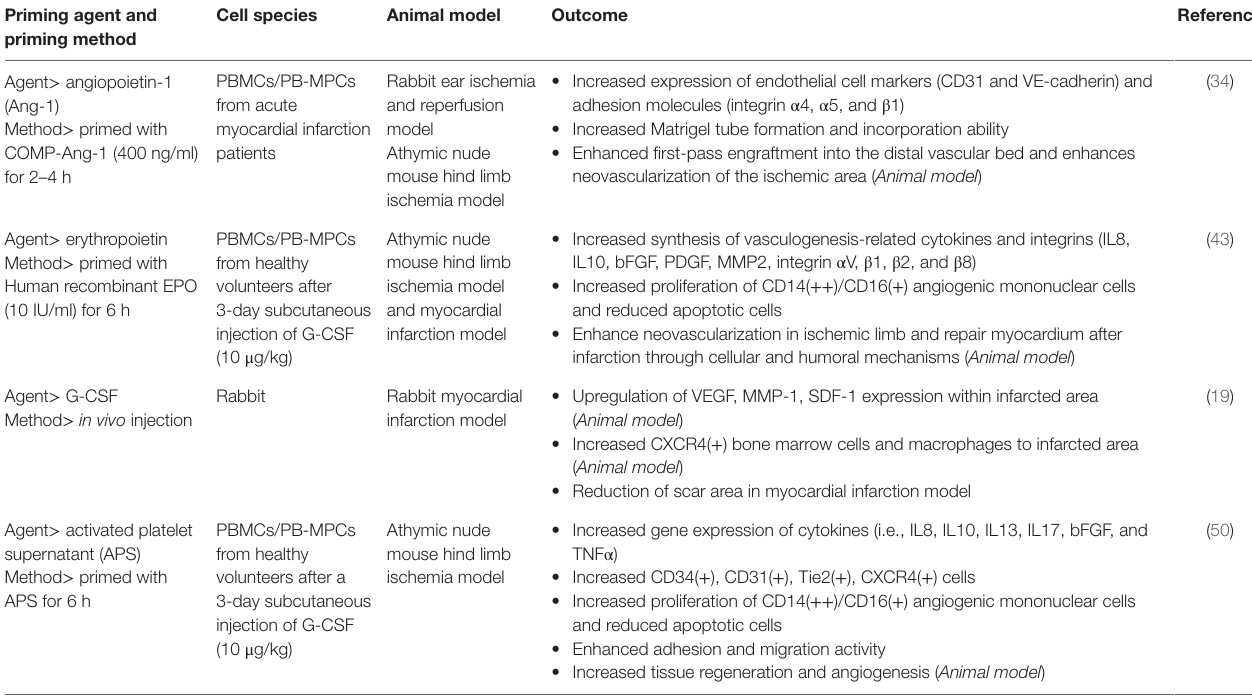
TABLe 2 | Study results of priming agents for peripheral blood mononuclear cells or peripheral blood mobilized-progenitor cells from the bone marrow. Priming agent and priming